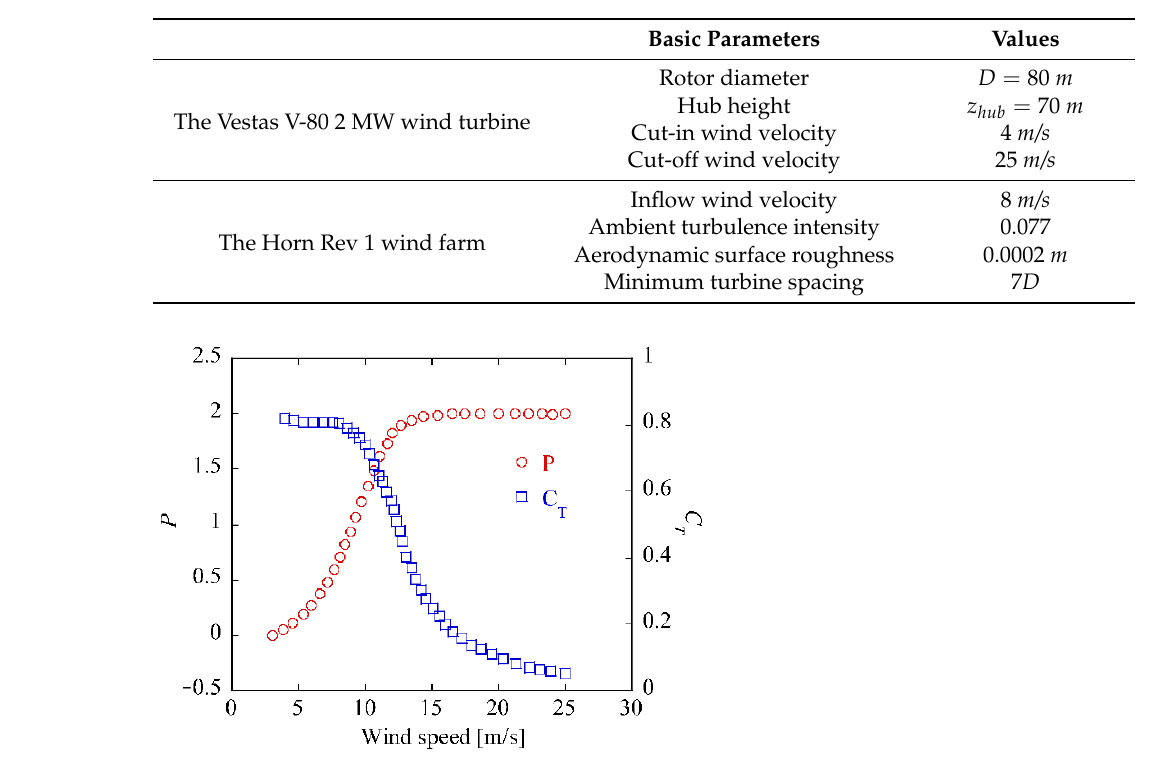
Table 6. Basic parameters of the wind turbine and operational conditions of the wind farm.